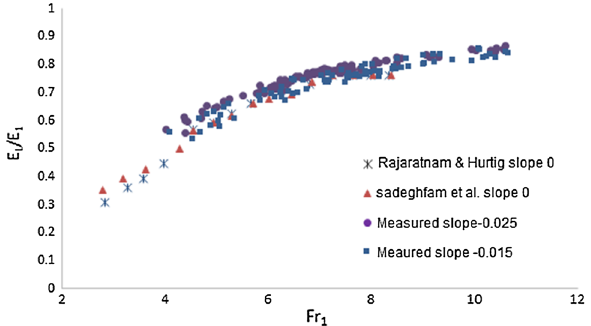
Fig. 8 The comparison of the relative energy dissipation E reverse bed slope with single screen for current and former